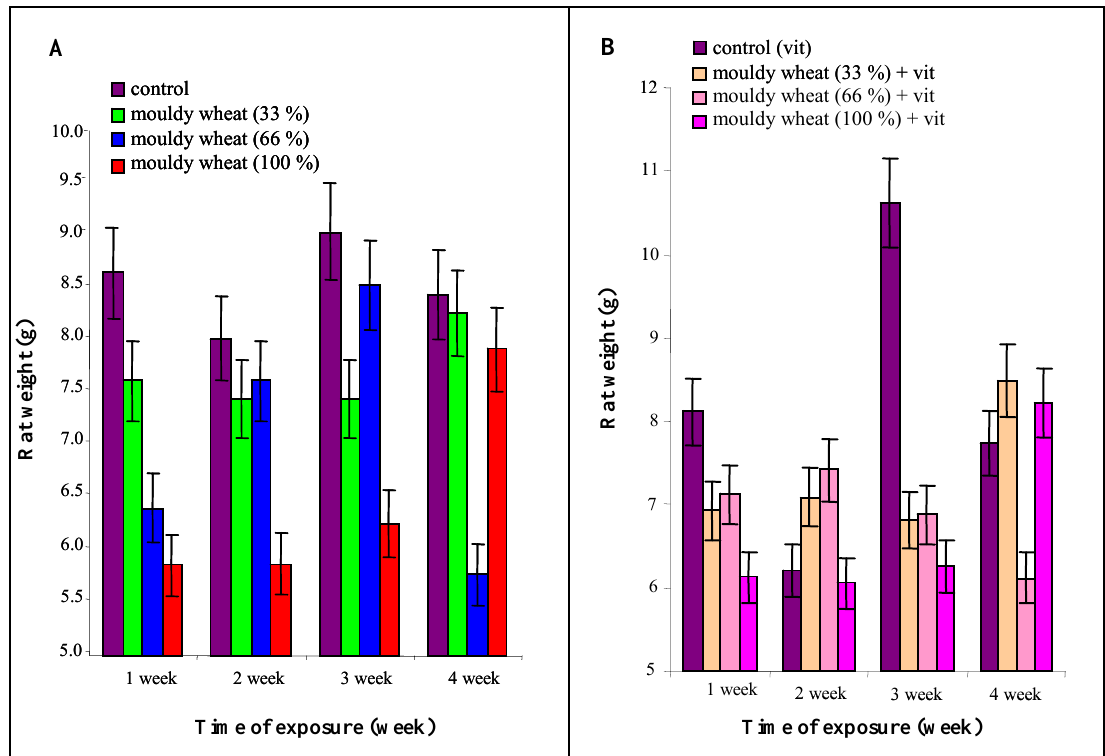
Figure 4. (A) Average weekly weight increase in rats administered various doses